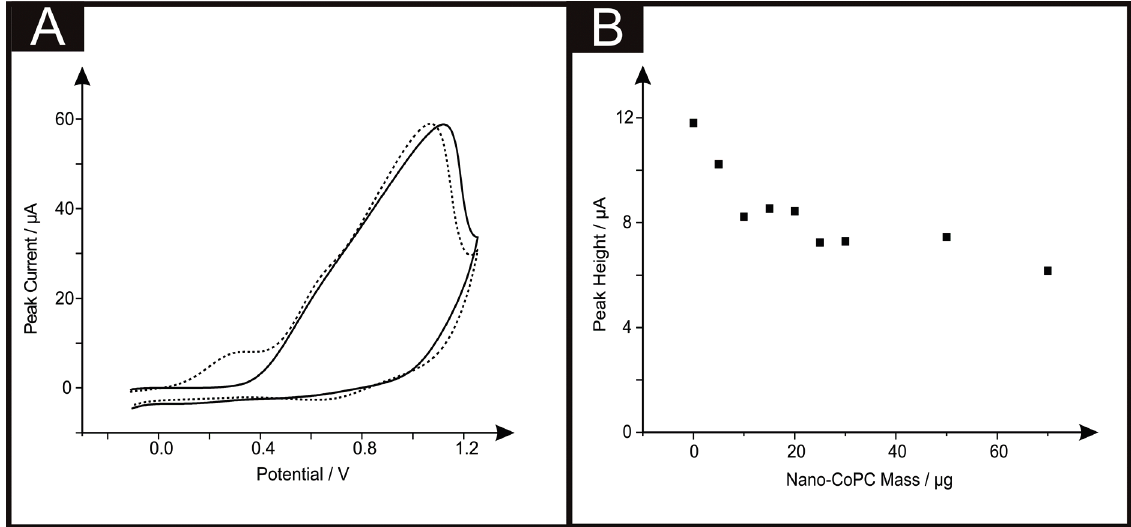
Figure 3. Cyclic voltammograms ( A ) in the presence (dashed line) and absence (solid line) of 1 mM L-ascorbic acid in pH 7.4 PBS utilising a standard-SPE modified with 20 µg nano-CoTAPC; ( B ) shows the corresponding plots of peak height (using the peak observed at ~ +0.30 V vs. SCE) as a function of varying amounts (mass) of nano-CoTAPC. Scan rate: 100 mV s − 1